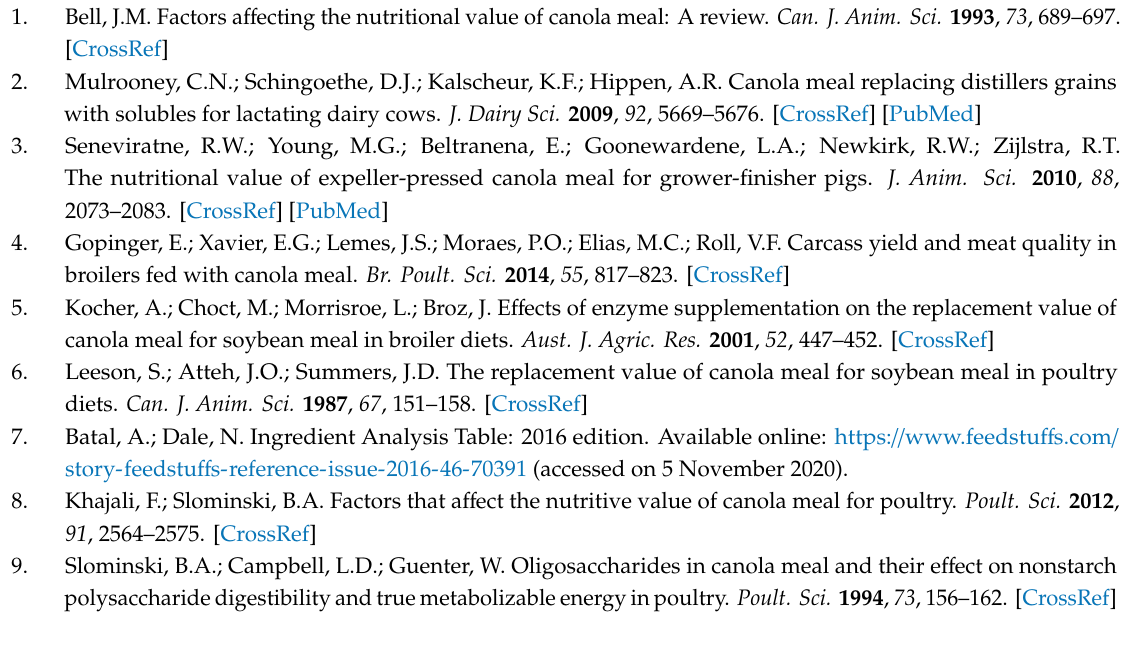
Figure S1: Enzyme discovery platform for the tailored degradation of non-starch dietary polysaccharides, Figure S2: Fractionated yield of cold-pressed and solvent-extracted canola meal (CM) plant cell wall extractions for glycomic linkage analyses, Figure S3: Cell wall linkage composition of solvent-extracted canola meal, Figure S4: Estimated polysaccharide composition of solvent-extracted canola meal, Figure S5: Temporal relative abundance of primary bacterial families in CON, NSP, and CM treatment bio-reactor vessels, Table S1: Linkage composition of cold-pressed canola meal whole cell wall (AIR) and fractions, Table S2: Linkage composition of solvent-extracted canola meal whole cell wall (AIR) and fractions, Table S3: CAZome of bacterial isolates for the GH5 and GH43